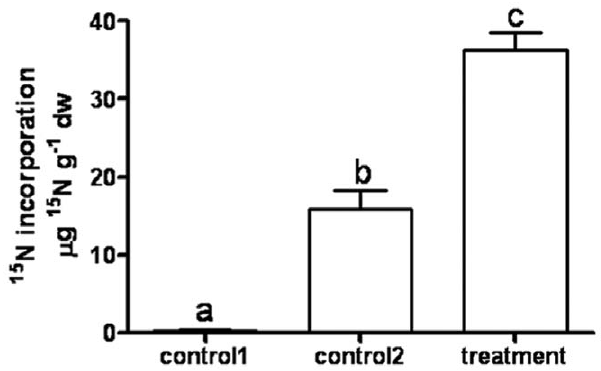
Figure 6. Incorporation of E. coli -derived 15 N by leaves of tomato plants. Roots of tomato grown in hydroponic culture were incubated with 15 N- E. coli for 1 h. After washing of the roots, plants were further grown for 2 weeks. Then 2–3 new leaves were analyzed for 15 N content. Control 1 are plants grown without 15 N- E. coli . Control 2 are plants incubated for 2 h with filtered 15 N- E. coli incubation solution. Results are depicted as mean 6 SD (n=7). Different letters indicate significant differences at p , 0.001 (1-way ANOVA, Tukey’s posthoc